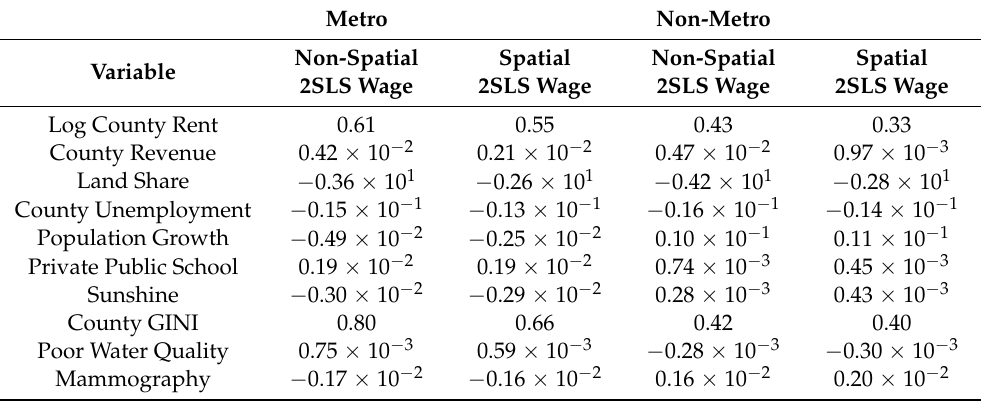
Table 3. Direct marginal effects for wage equations: non-spatial versus spatial 2SLS in the continental United States.